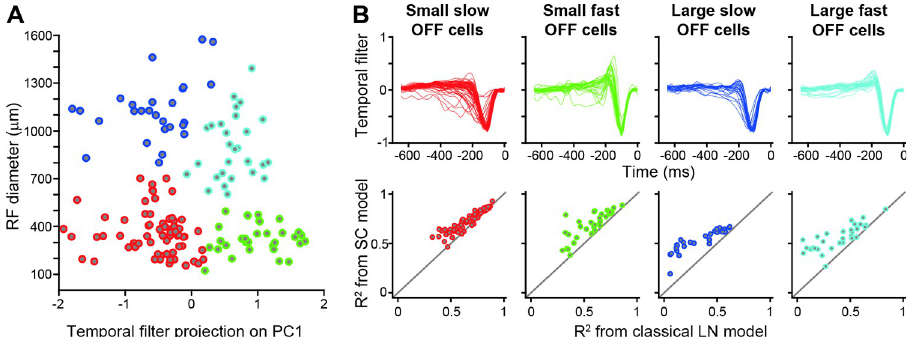
Fig 4. Evaluation of LN and SC model separately for four functional classes of salamander ganglion cells. A) Scatter plot of receptive-field diameter versus the projection of the temporal filter on the first principal component of all temporal filters. Temporal filters were obtained from the spike-triggered average under spatiotemporal white-noise stimulation. The colors mark the four clusters that were determined by k-means clustering. B) Collection of all temporal filters (top) and display of model performance values for the two models, separately for the four cell classes (number of cells: 66 small slow OFF cells, 33 small fast OFF cells, 27 large slow OFF cells, 30 large fast OFF cells).